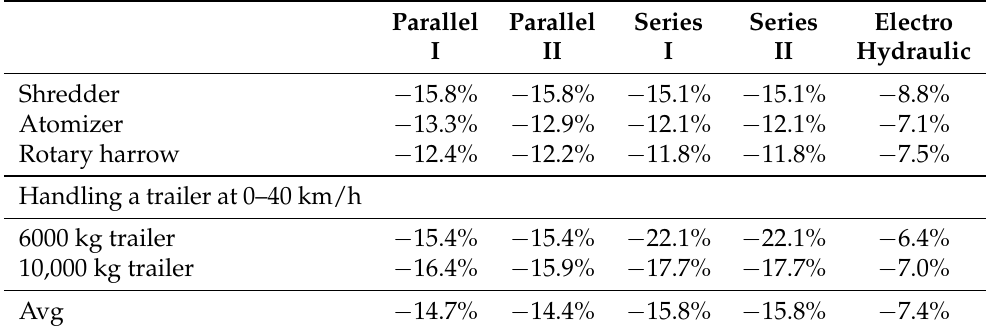
Table 7. Energy consumption in CD mode compared to the conventional